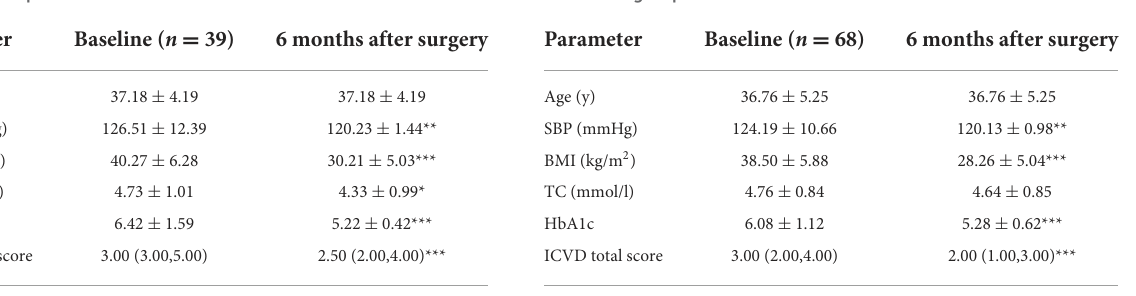
TABLE 3 Baseline and 6-month-post-operative characteristics in the female